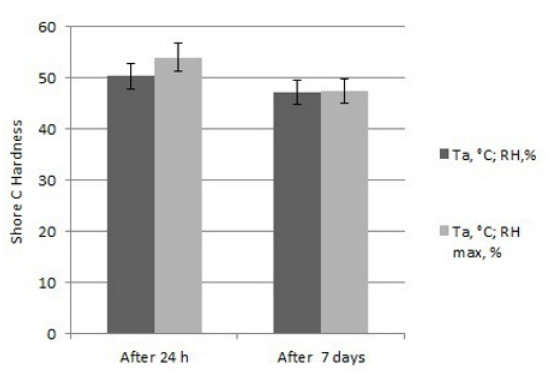
Figure 4. Variation in Shore C hardness of samples prepared at dif- ferent RH, % measured after several formation times (- NCO 2.4%, binder content 8 wt. %, formation pressure 0.008